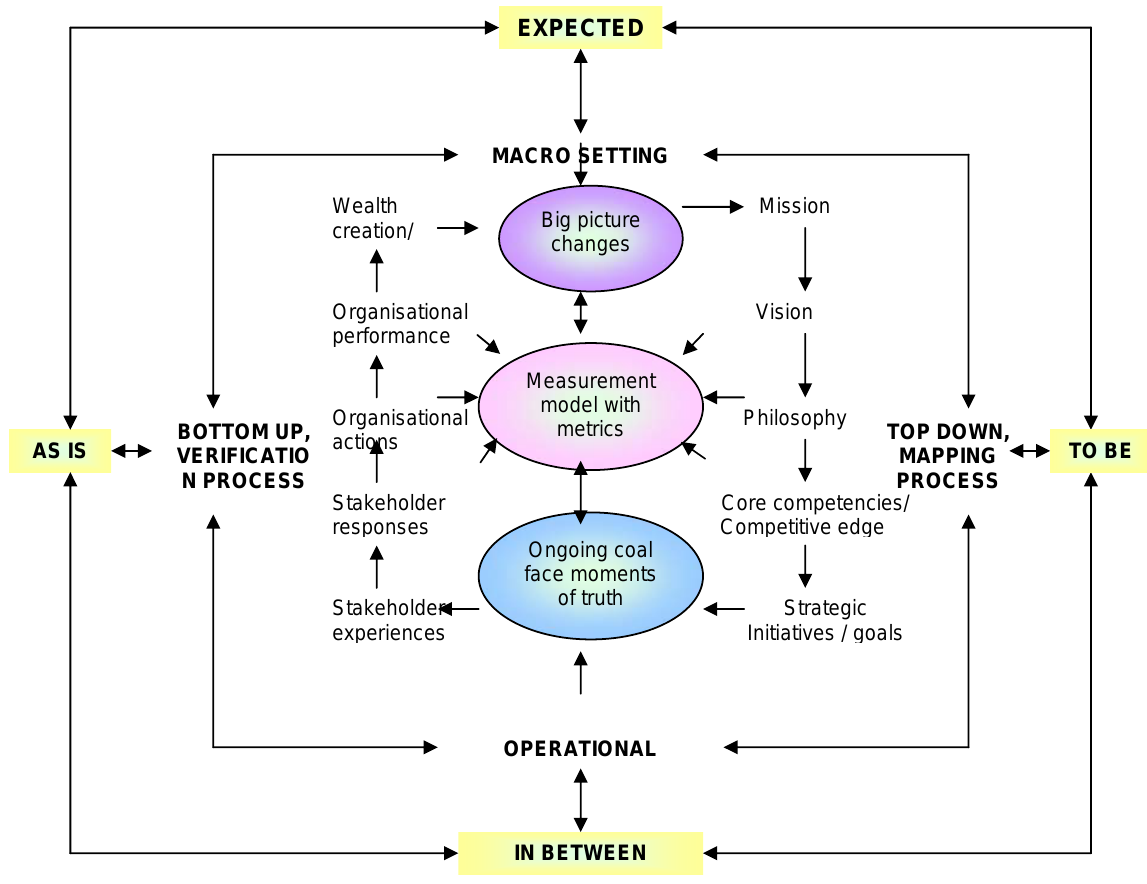
Figure 5: Strategising as an everyday, ongoing living